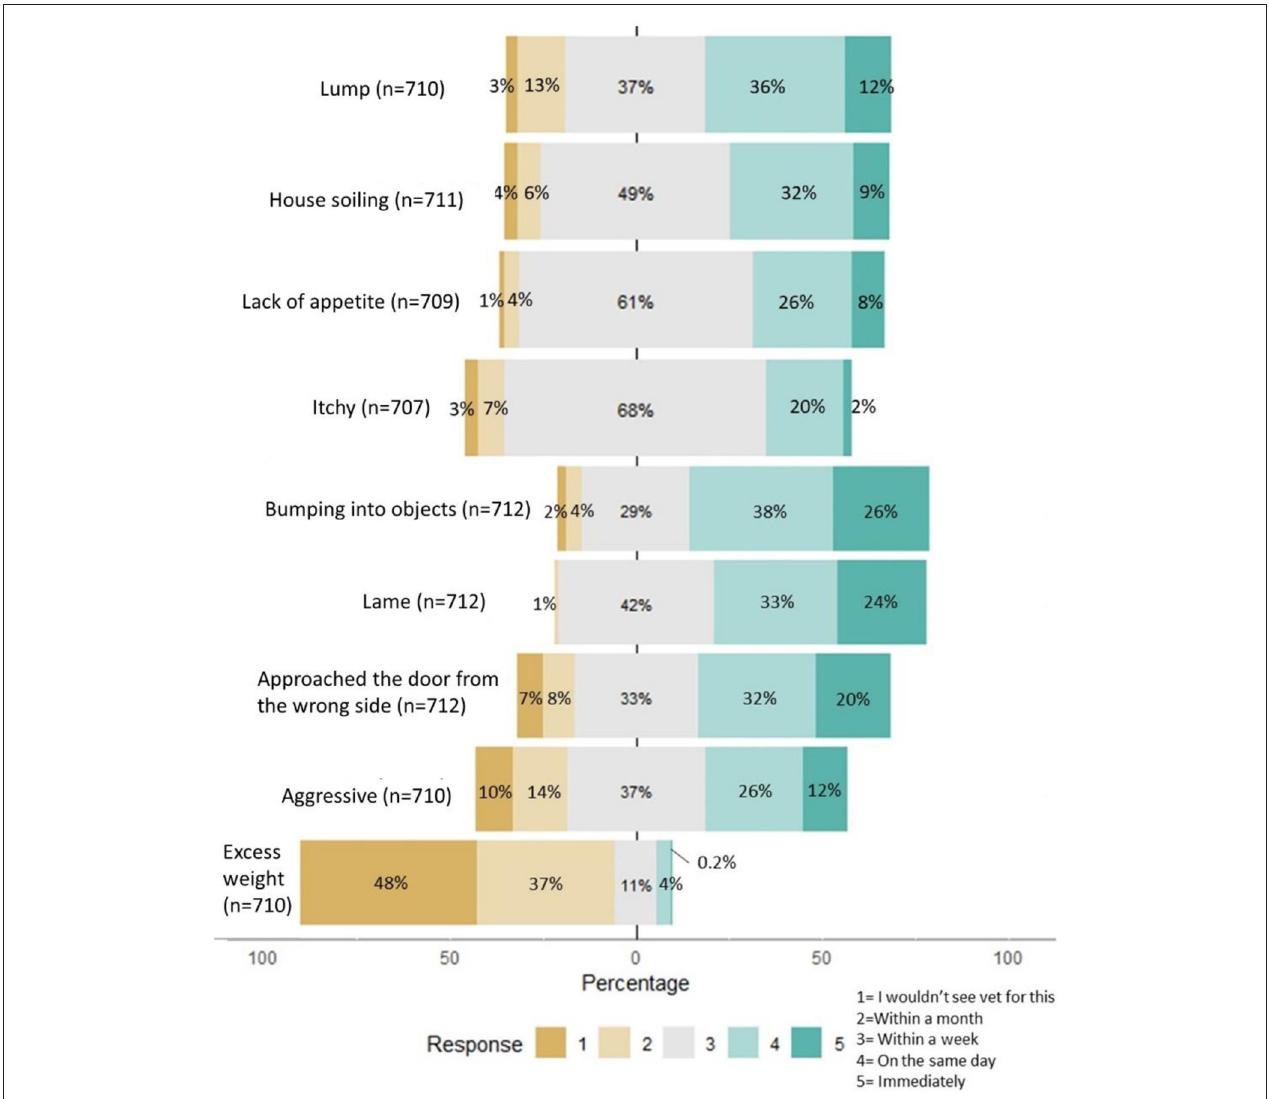
FIGURE 2 | Summary of responses to questions about urgency to seek care given dog showing symptoms that could indicate common chronic health conditions.